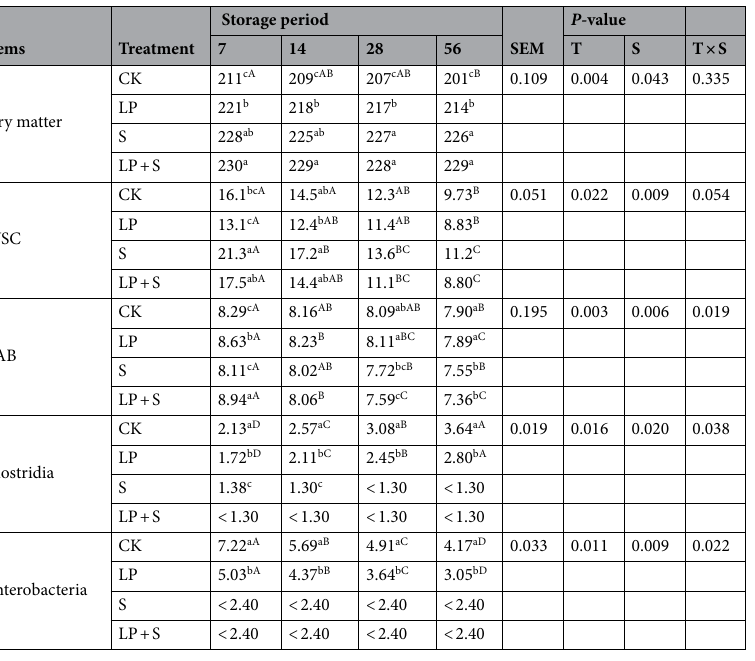
Table 3. Effect of different additives on dry matter (g/kg FM), WSC (g/kg DM) and microbial counts (log 10 cfu/g FM) of alfalfa silage during ensiling. a–d Means within a column with different superscripts differ ( P < 0.05); A–E Means within a raw with different superscripts differ ( P < 0.05); LAB, lactic acid bacteria; LP, Lactobacillus plantarum ; S, sucrose; LP + S, the addition of both sucrose and Lactobacillus plantarum ; WSC, water soluble carbohydrates; DM, dry matter; FM, fresh matter; T: effect of treatment; S: effect of storage period; T × S: interaction between treatment and storage period; SEM, standard error of